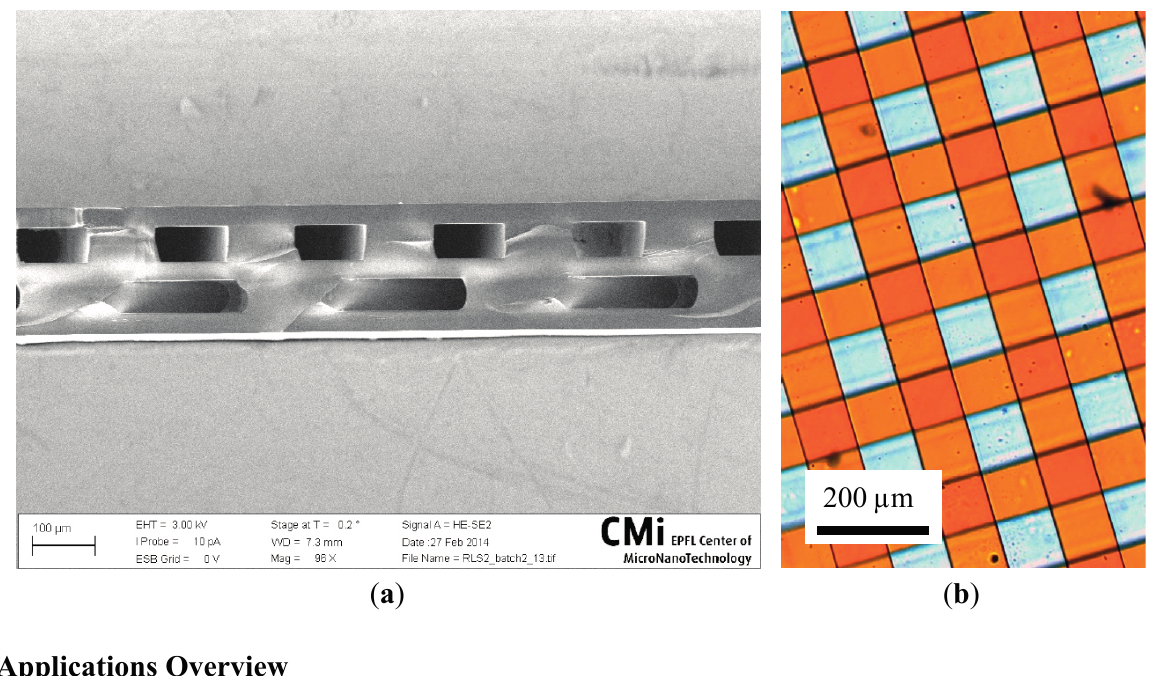
Figure 6. ( a ) SEM image showing an oblique cross section of the 200 µm thick, monolithic SU-8 chips integrating two microchannel layers. The microchannels are 100 µm wide and 50 µm deep, while the pitch is 200 µm. These dimensions were chosen to match the pixel positions of the Hamamatsu (Hamamatsu, Japan) S8866-128-02 photodiode arrays. (b) Optical micrograph from the top showing the same microchannel network filled with a